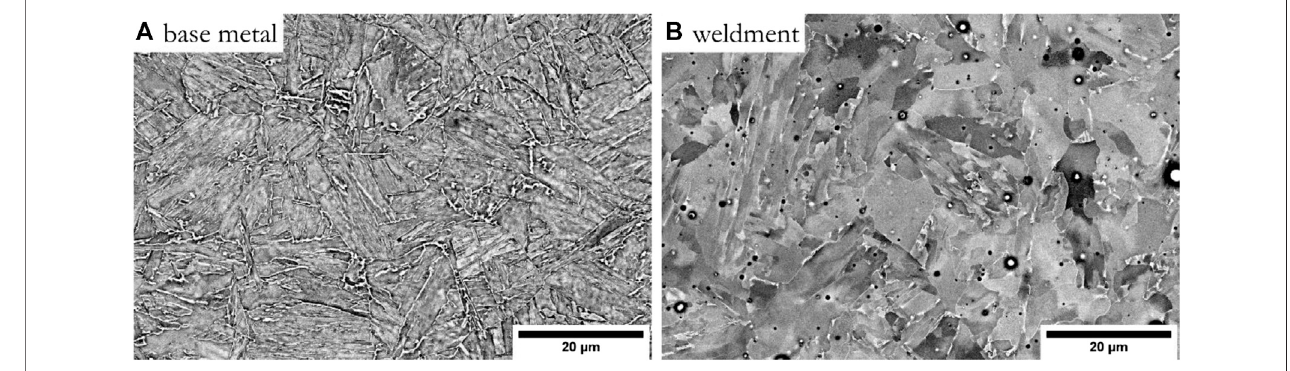
FIGURE 11 | SEM comparison of (A) base metal and (B) weldment.